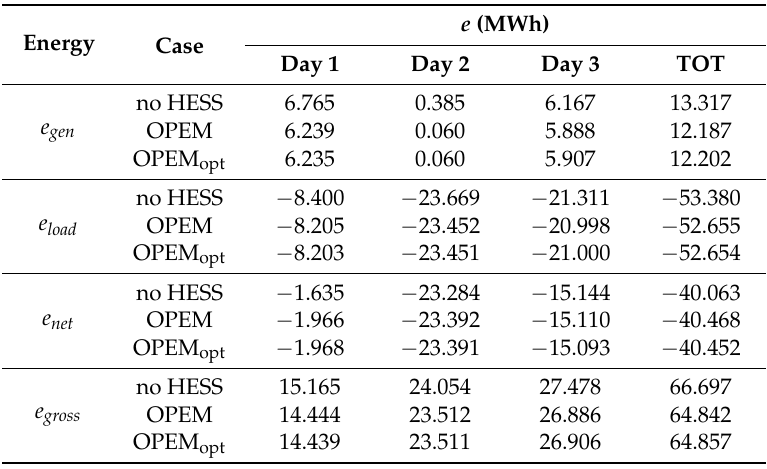
Table 7. OPEM energy